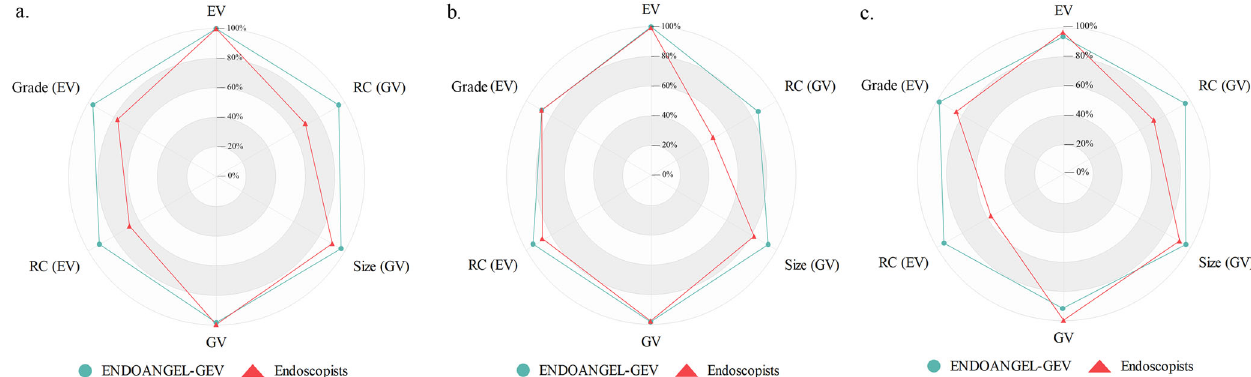
Fig. 4 Comparison of the results between ENDOANGEL-GEV and endoscopists on dataset 3(Prospective study). Radar maps illustrate the accuracy ( a ), sensitivity ( b ), and speci fi city ( c ) on dataset 3. In this fi gure, grade 1 is regarded as small, and grade 2 – 3 is seen as large for classifying grade. EV esophageal varices, GV gastric varices, RC red color